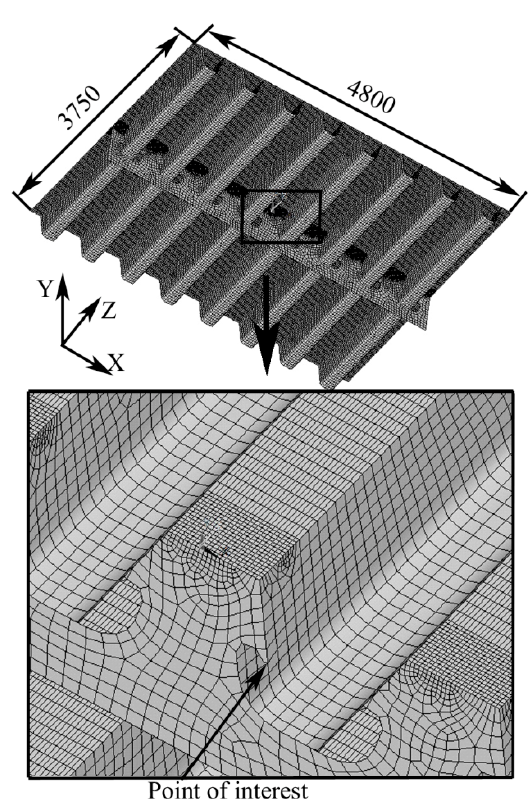
Figure 2. finite element (FE) model and the interest point of the rounded welding region.